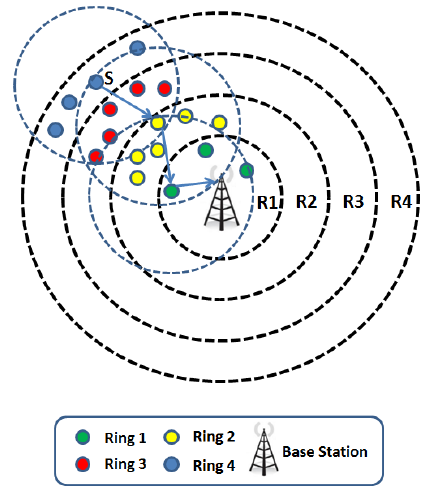
Figure 3. Routing scheme used in RARZ.